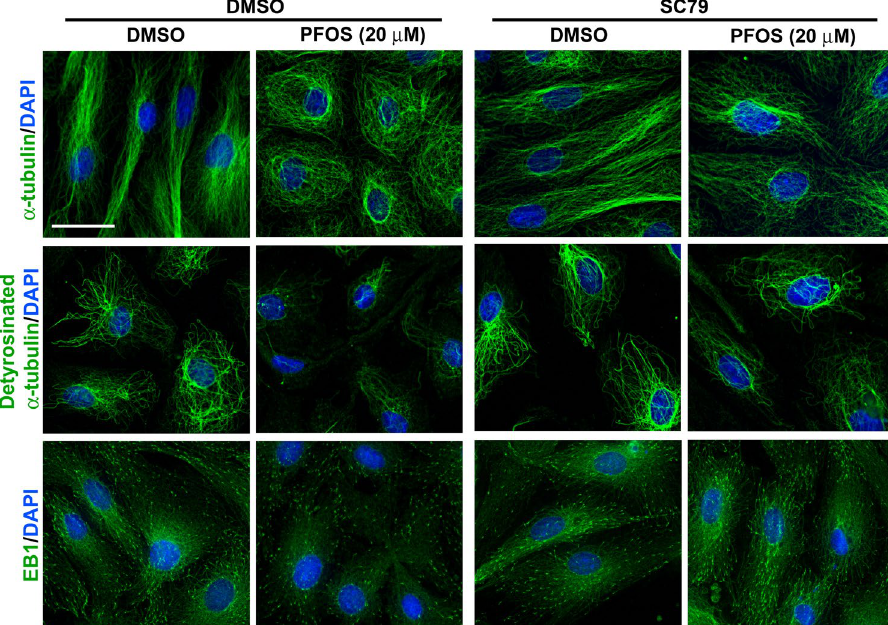
Figure 6. Akt activator SC79 blocks PFOS-mediated MT (e.g., α -tubulin and detyrosinated α -tubulin) disorganization by attenuating disruptive distribution of EB1. Sertoli cells cultured for 3 days at a density of 0.03 × 10 6 cells/cm 2 . Cells were pre-treated with 2 μ g/ml SC79 (5.5 µ M) for 30 min, and then cells were rinsed and treated with PFOS at 20 µ M for 24 hr. Thereafter, cells were fixed with ice-cold methanol and visualized by immunofluorescence microscopy using corresponding antibodies (Table 1). Consistent with data shown in Fig. 5, PFOS induced disorganization of MTs by disrupting the organization of α -tubulin and detyrosinated α -tubulin across the Sertoli cell cytosol and also + TIP EB1. However, SC79 blocked the PFOS-mediated MT disorganization, possibly by attenuating disruptive distribution of EB1 in SC79 pre-treated cells. Sertoli cell nuclei were visualized by DAPI. Scale bar, 30 µ m, which applies to all other